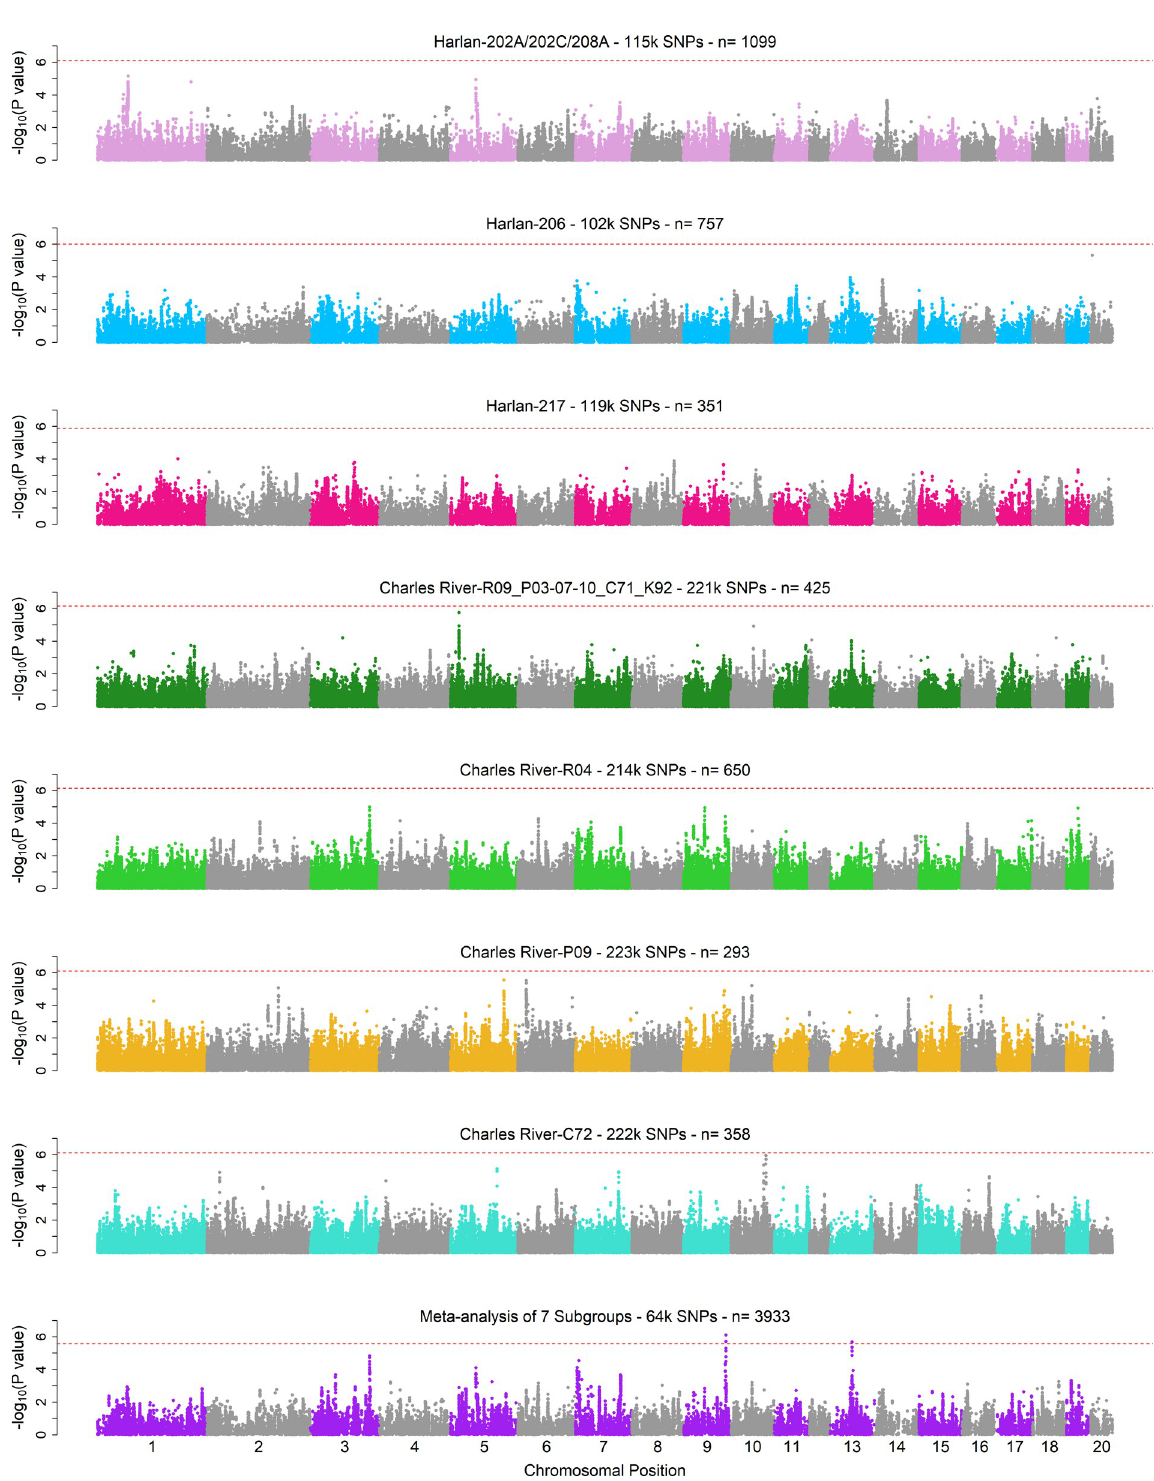
Fig 4. Manhattan plots for the GWAS on PavCA Index Score on day 5 in each subgroup and the meta-analysis. The titles above each of the eight Manhattan plots indicate the population, number of SNPs, and sample size for each depicted GWAS. The y-axis is the -log 10 of the p-value from the likelihood-ratio test performed by GEMMA. The x-axis is the genomic coordinate of the variants within each chromosome, in ascending order of chromosome.